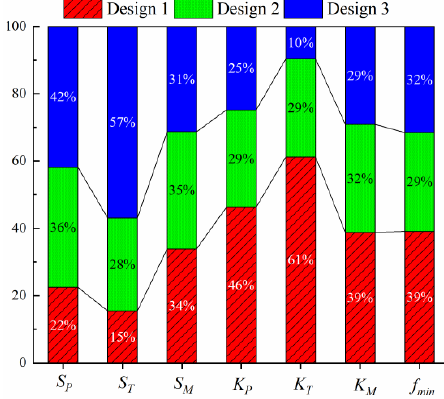
Figure 9. Performance comparison of three designs.